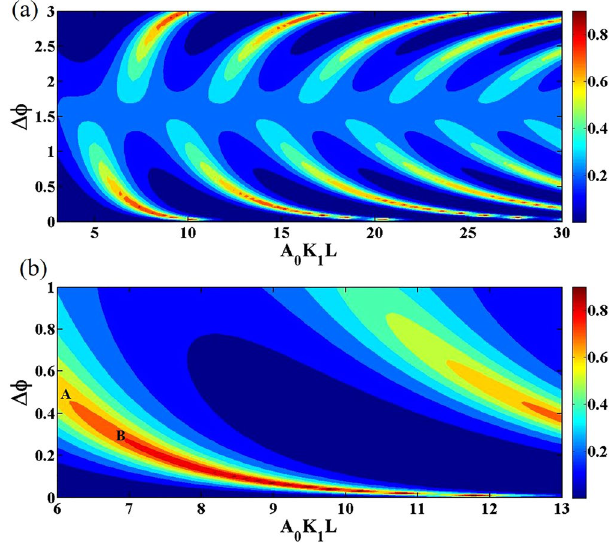
Figure 4. Distribution of non-reciprocity parameter with different values of Δ ϕ under the condition that A 0 K 1 L 1 = 0.3 π . Different color represents different nonreciprocal